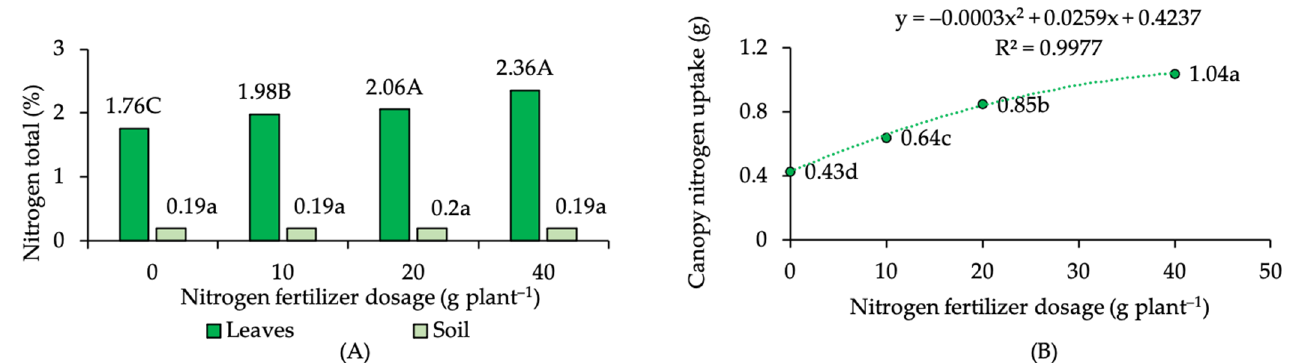
Figure 1. ( A ) Bar chart of nitrogen status on kaffir lime leaves and soil, and ( B ) regression curve of kaffir lime canopy nitrogen uptake under different nitrogen-fertilizer dosage. Note: mean values followed by the same letter are not significantly different based on DMRT at α 0.05. Table 1. Pearson correlation analysis between nitrogen status, characteristics of production and physiology of kaffir lime.